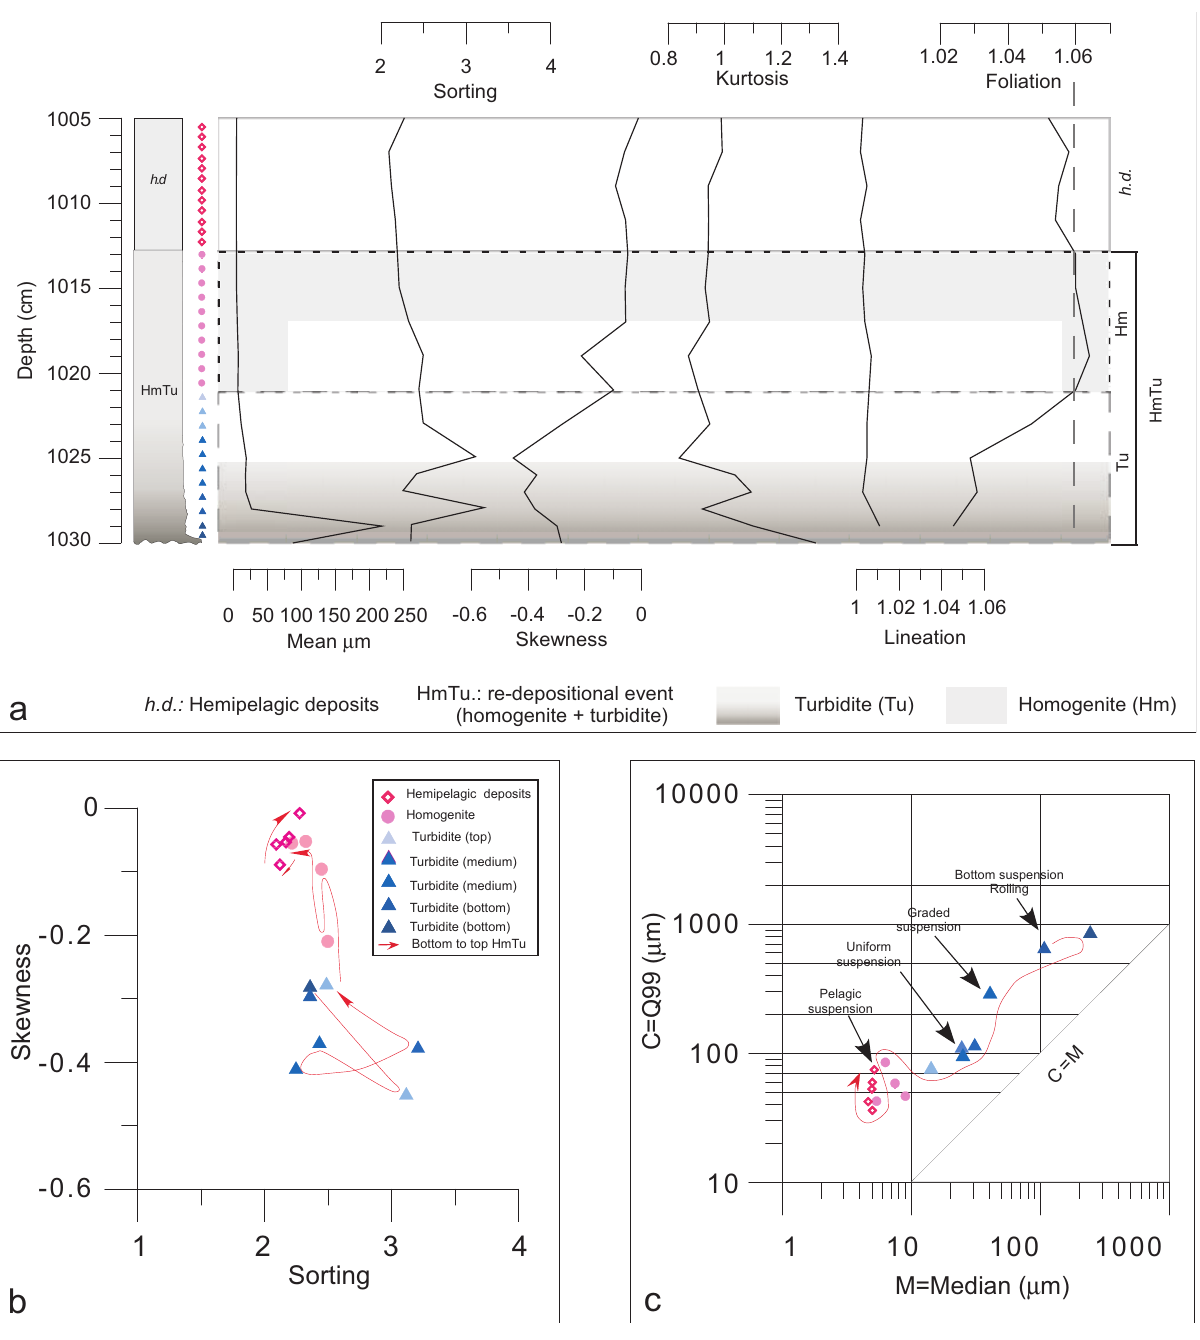
Figure 4. Textural characterization of Homogenite+Turbidite (HmTu) A (1005-1030 cm; location on Figure 2). a) main granulometric pa- rameters and MSA values; b) Sk index vs. So index bottom-to-top path; c) bottom-to-top path on Passega [1964]’s